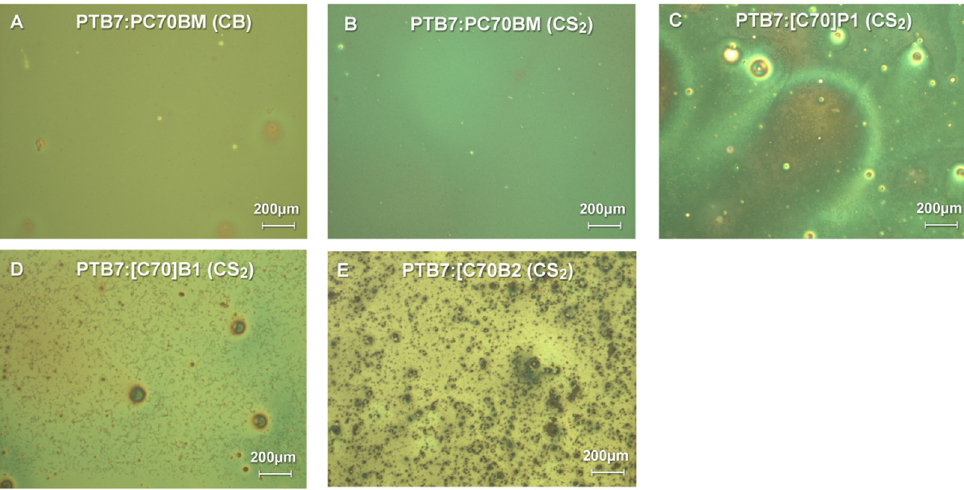
Figure 10. Optical microscopy images with differential interference contrast of solar cells prepared using PTB7 and synthesized C 60 /C 70 pyrene derivatives and CS 2 or CB as solvents.